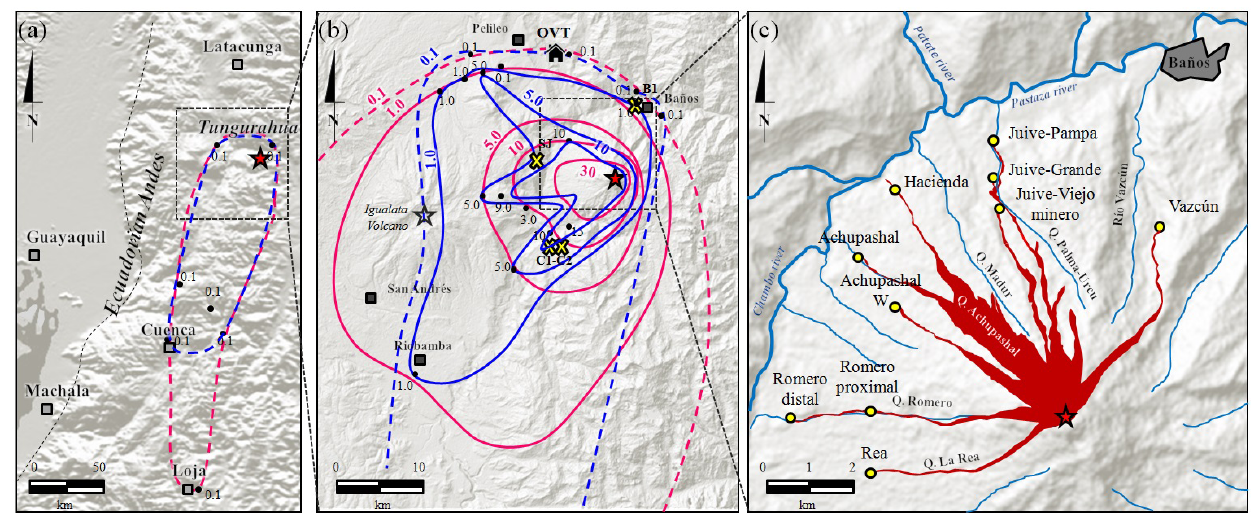
Figure 1. Pyroclastic deposits of the February 2014 eruption of Tungurahua volcano. (a, b) Isopach maps of tephra fall deposits associated with the 1–14 February 2014 eruptive period in millimetres (magenta: scenario A; blue: scenario B). Black circles: field measurements ; yellow crosses: samples for grain-size analysis. See Fig. 5 for details on the field observations. (a) Distal and (b) proximal distribution. (c) Distribution of PDCs from the 1 February eruption (red area), modified after Hall et al. (2015). Yellow circles represent the position for the field observation of PDC fronts (Table